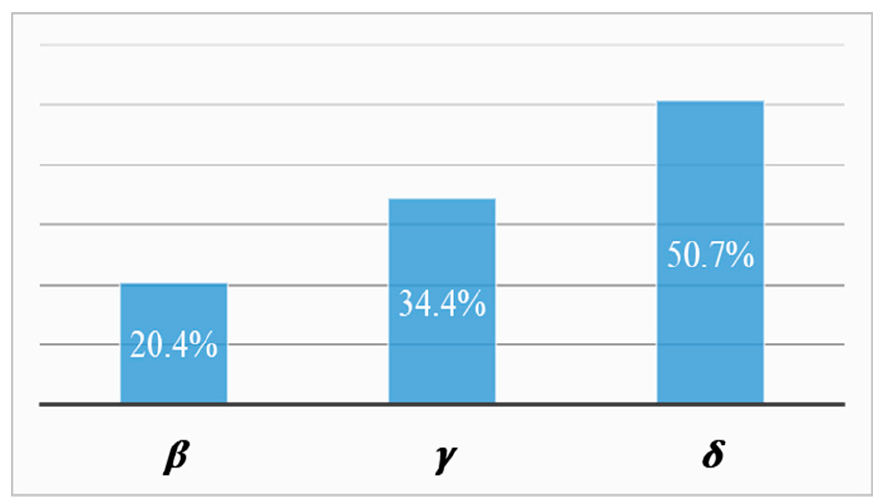
Figure 12. Variable of importance: the %IncMSE.